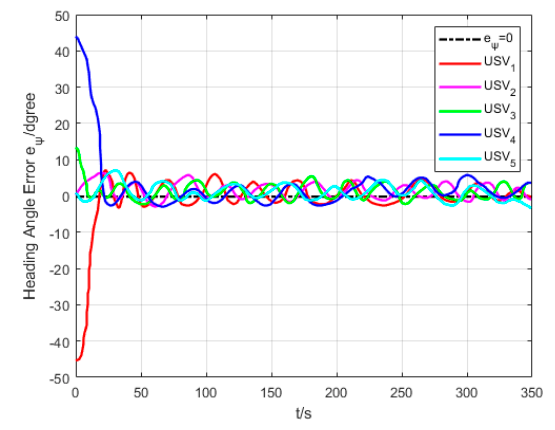
Figure 25. Heading angle error (Algorithm 4).